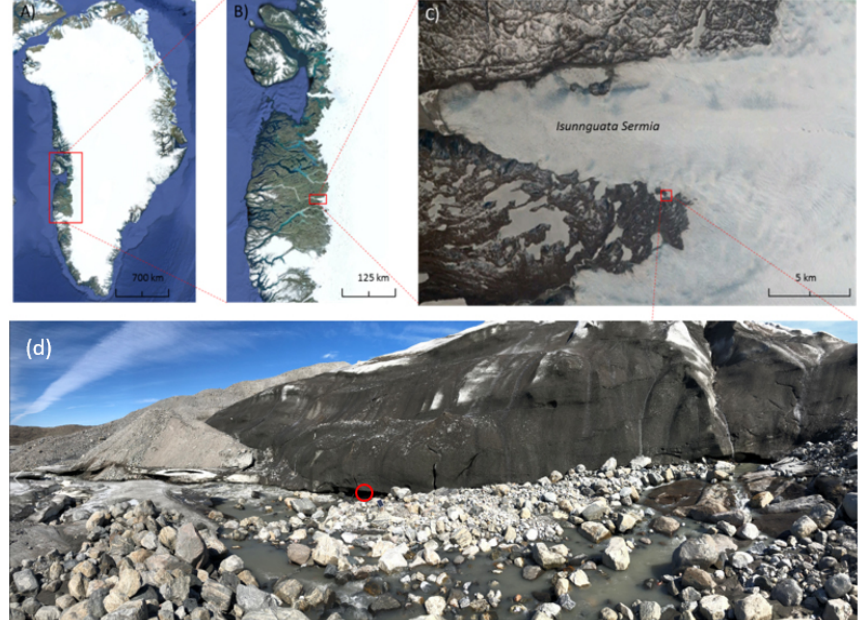
Figure 1. Overview of the sampling location at Isunnguata Sermia Glacier at the western margin of the Greenland ice sheet during June 2018. (a) Location of sampling region the island of Greenland, (b) regional location of the outlet glacier, (c) location of the meltwater outlet at Isunnguata Sermia, and (d) local sample location, with investigated subglacial cavity marked with red circle. Source of (a, b, c) : © Google Earth, https://earth.google.com/web/ (last access: 23 April 2020).